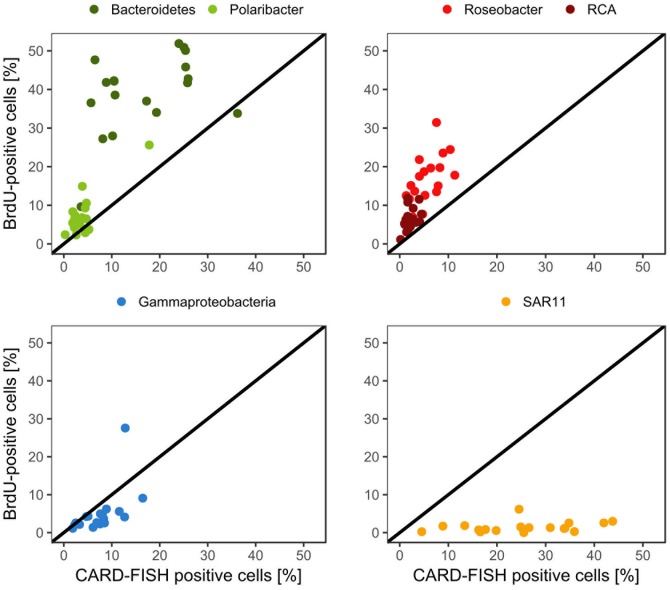
Relative abundances of the Roseobacter group and its RCA cluster, Bacteroidetes and its Polaribacter cluster, the SAR11 clade and of Gammaproteobacteria assessed by CARD-FISH and BrdU-FISH during early summer in the North Sea between 54° and 58°N. The red dots represent the Roseobacter group without the RCA cluster and the dark green dots Bacteroidetes without the Polaribacter cluster. The diagonal line indicates equal percentages of the cells assessed by both methods.